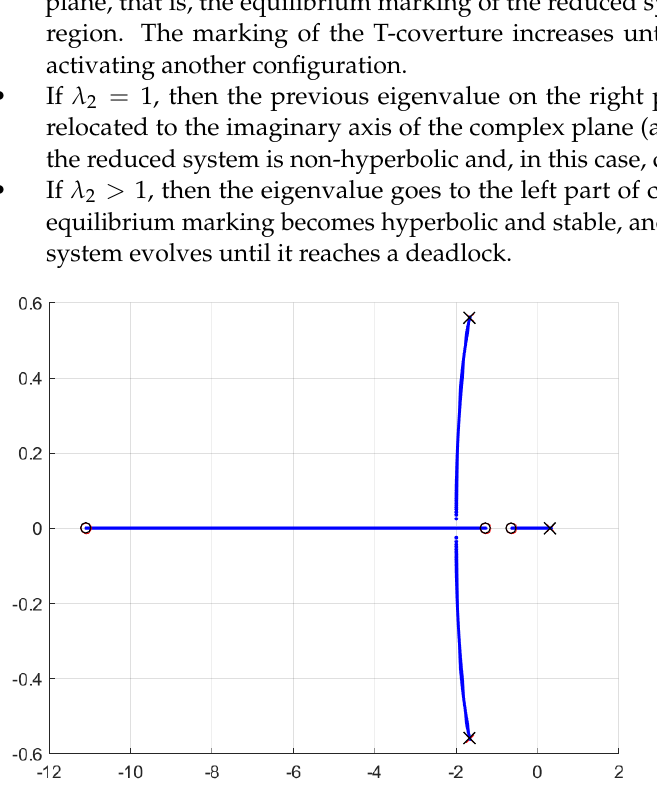
Figure 6. Location of three of the eigenvalues of matrix A C on the complex plane when λ 2 is varied from zero to ten. When λ 2 is close to zero, the eigenvalues are located on the ‘X’ symbol. By increasing λ 2 , the eigenvalues move through the blue line until they reach the ‘O’ symbol, where the value of λ 2 is